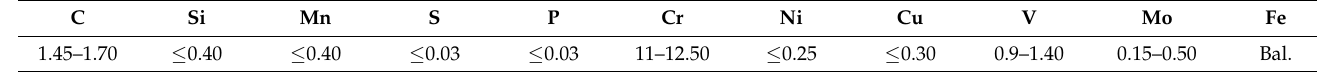
Table 1. Cr12MoV steel chemical composition.